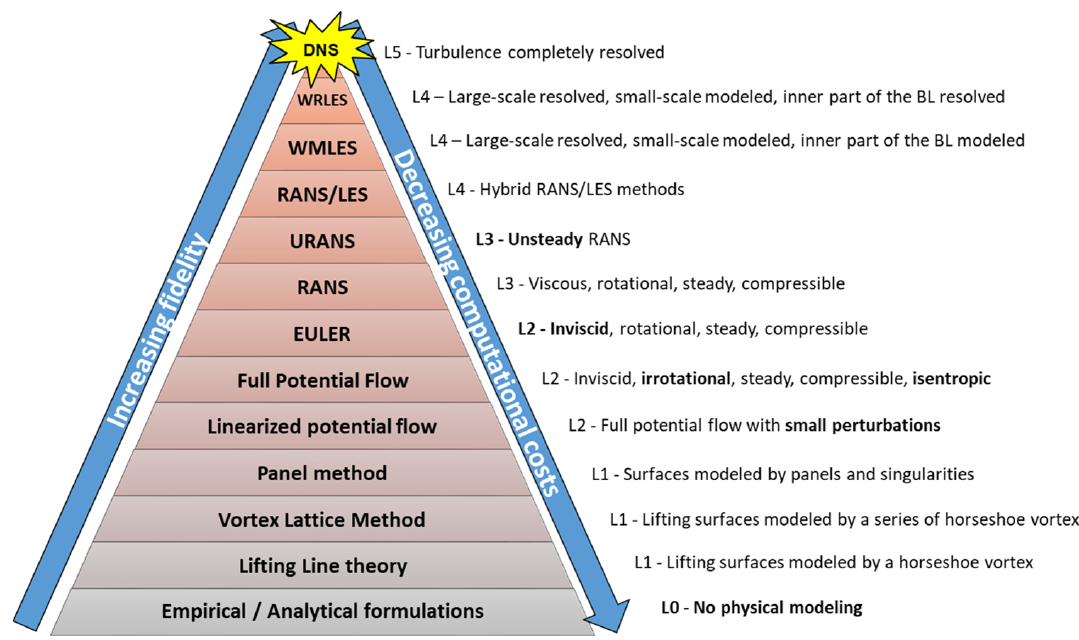
Figure 1. The different fidelity levels for flow physics modeling of the aerodynamic solvers.